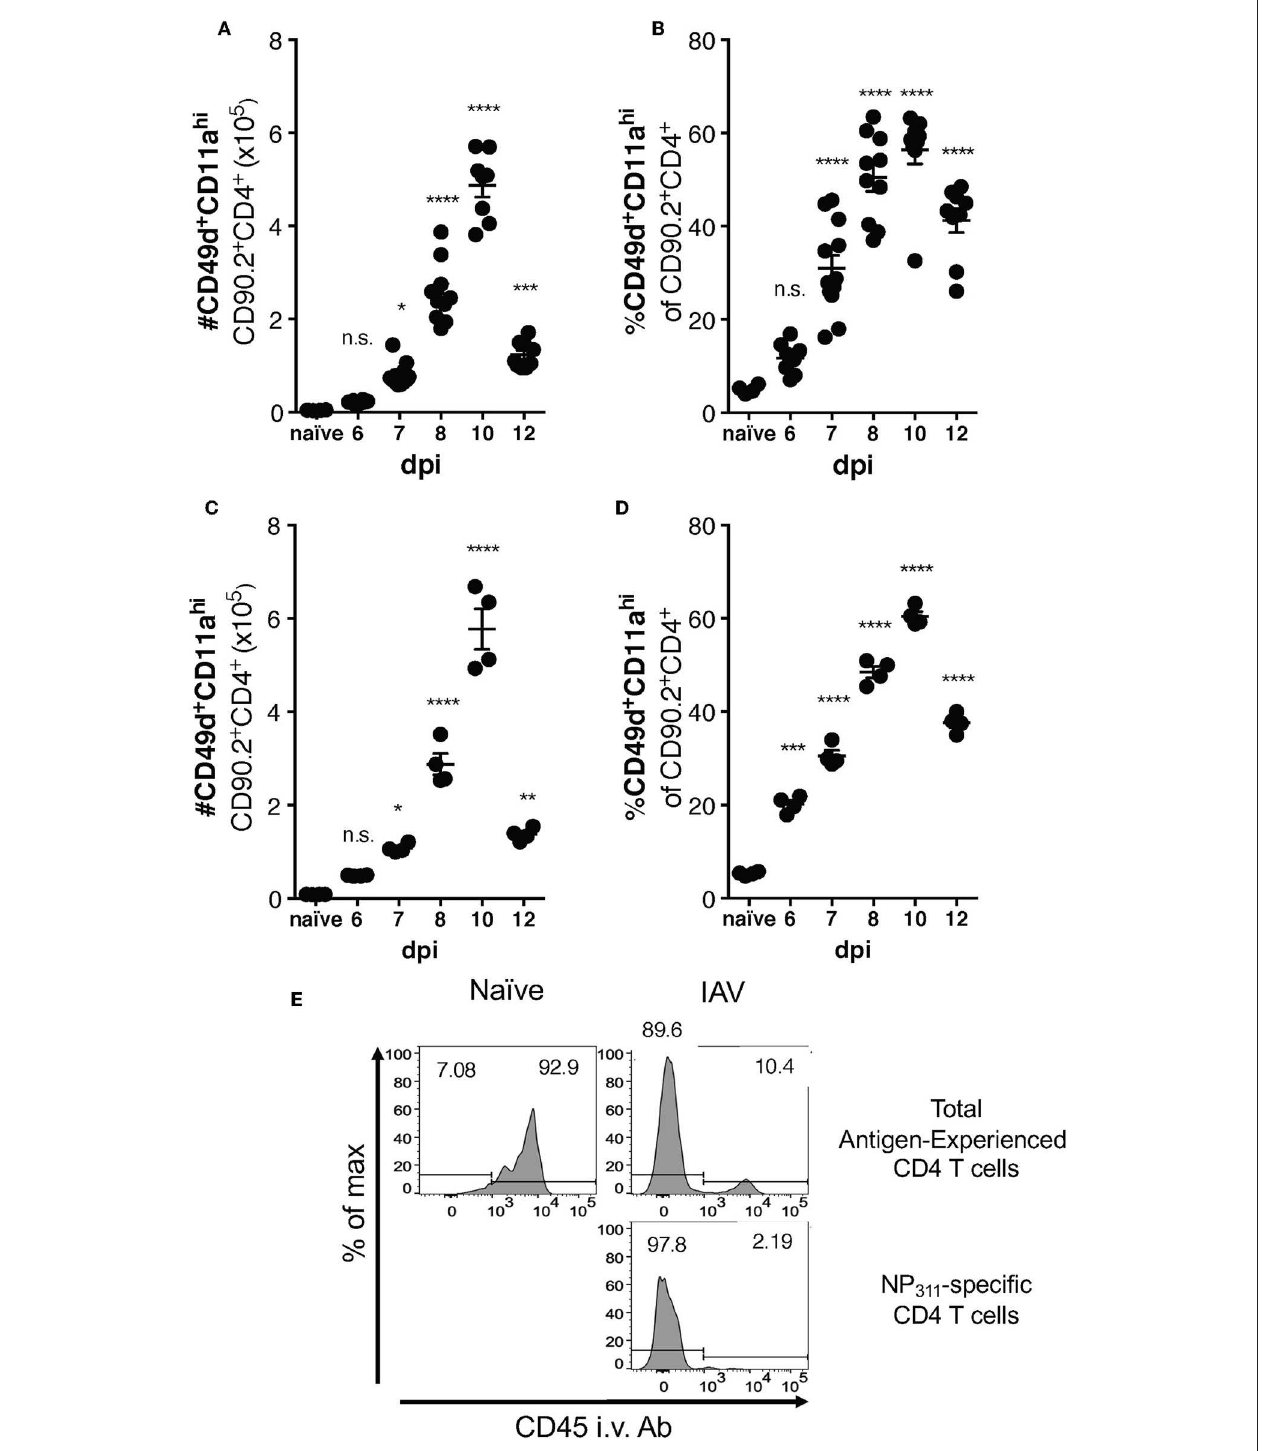
FIGURE 3 | Accumulation of IAV-specific CD4T cells in the lungs occurs with similar kinetics in C57Bl/6 and BALB/c mice. C57Bl/6 (A,B) and BALB/c (C,D) mice were infected with a 0.05LD 50 dose of IAV and then the lungs were harvested and stained for surface expression of CD49, CD11a, CD90.2, and CD4 at indicated time points. A group of naïve mice was included as a control. Number (A,C) and frequency (B,D) of CD49d + CD11a hi CD90.2 + CD4 + T cells were quantified by flow cytometry. Each point represents one mouse and mean and SEM are shown. n = 4–10 mice, representative of at least three independent experiments for each mouse strain. * p < 0.05, ** p < 0.01, *** p < 0.001; **** p < 0.0001, vs. naïve values. (E) C57Bl/6 mice were infected with a 0.1LD 50 dose of IAV on day 10 p.i. the fraction of indicated T cells within the lungs or the circulation vs. measured via administration of anti-CD45-BV421 mAb i.v. 3min prior to harvest.